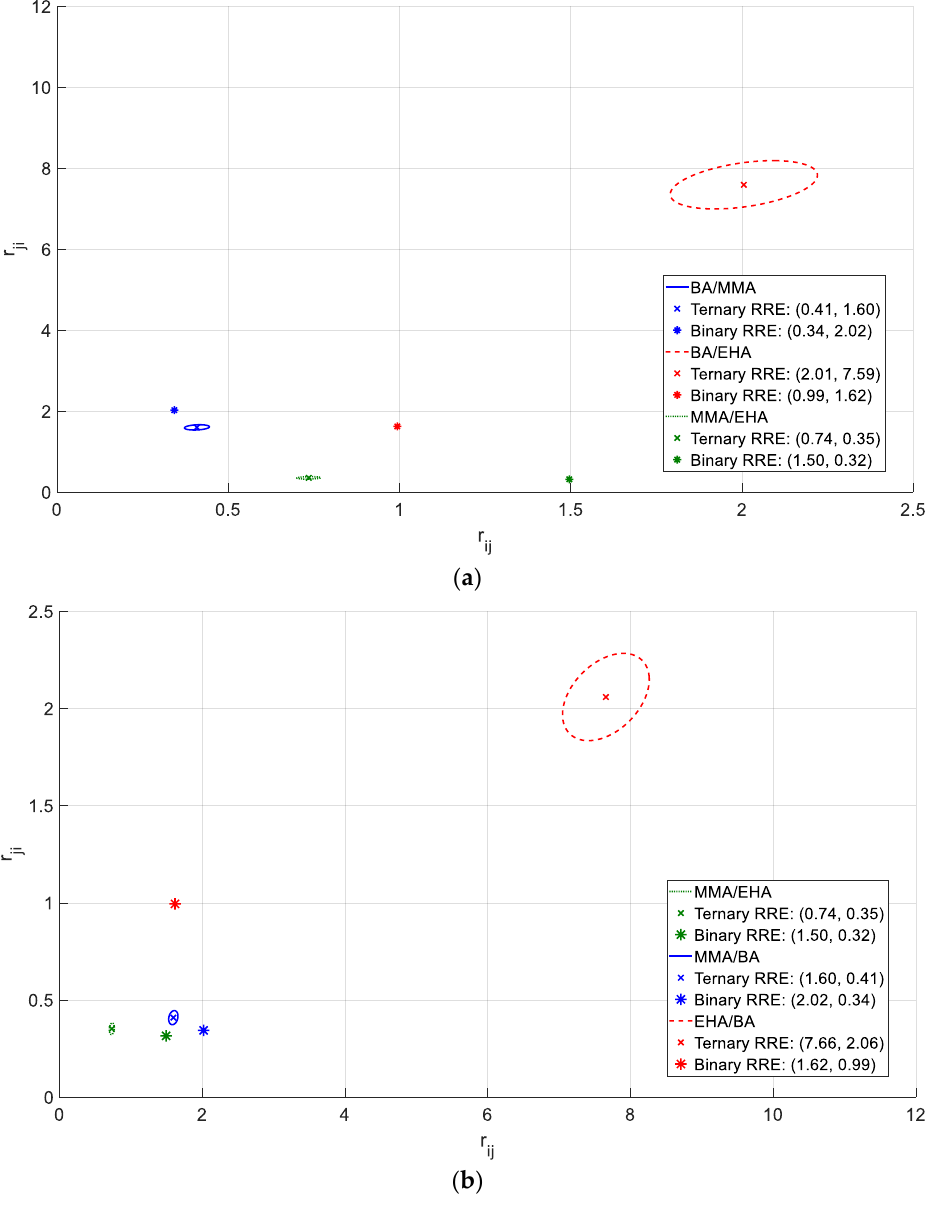
Figure 7. ‘Ternary’ reactivity ratio estimates for the terpolymerization of BA/MMA/EHA for ( a ) M 1 /M 2 /M 3 = BA/MMA/EHA and ( b ) M 1 /M 2 /M 3 = MMA/EHA/BA, with cumulative data from [12].